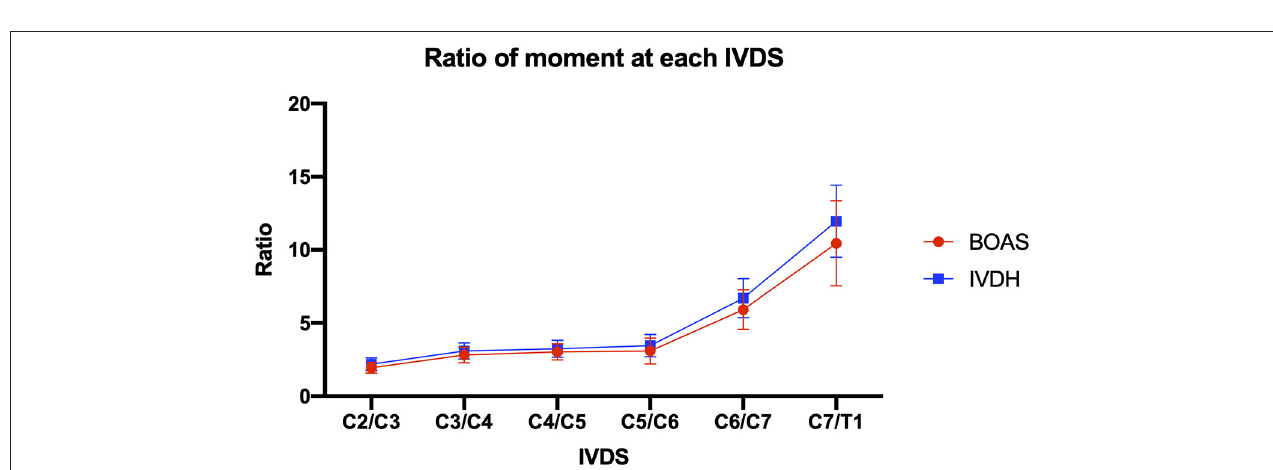
FIGURE 9 | Line graph showing mean ratio of moments of the cervical paraspinal musculature from IVDS of C2/C3 to C7/T1 in French bulldogs of the BOAS group (red line) and the IVDH group (blue